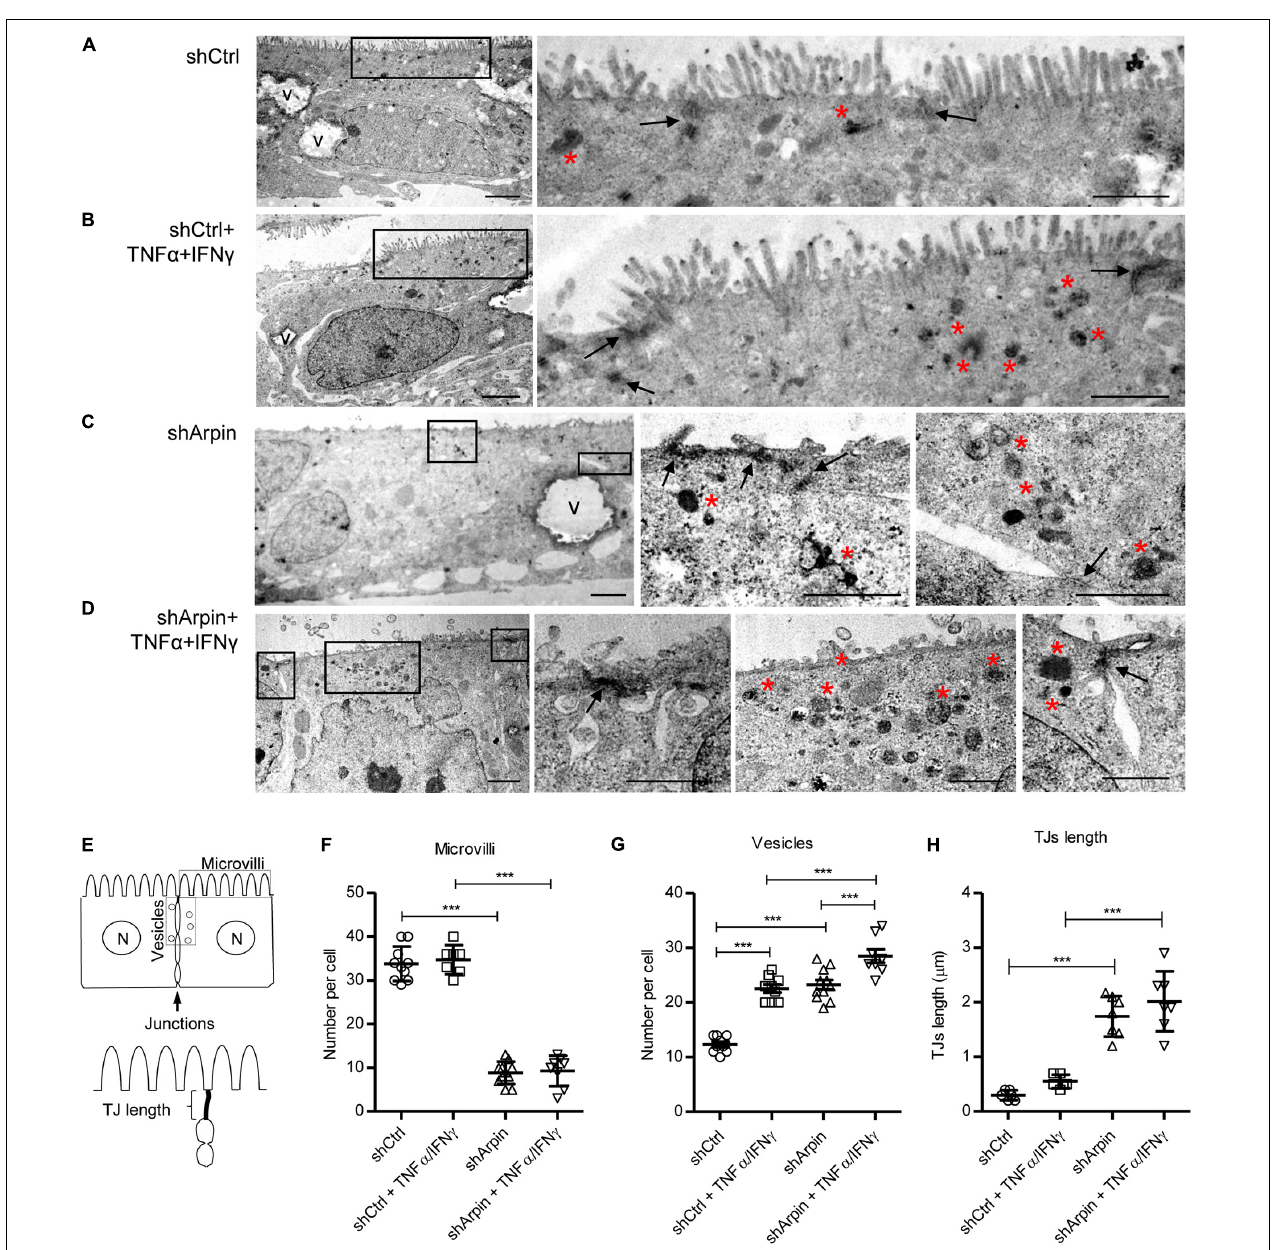
FIGURE 3 | Arpin depletion alters the ultrastructure of intestinal epithelial cells. Morphology of resting (A) and tumor necrosis factor (TNF) α /interferon (IFN) γ -treated (B) control cells (shCtrl). Morphology of resting (C) and TNF α /IFN γ -treated (D) arpin-depleted cells (shArpin). In the low-magnification micrographs on the left, overall morphology of entire epithelial cells can be observed (V, vacuoles; bar = 2 µ m). Frames indicate areas from which the high-magnification images (on the right) were taken. Arrows indicate tight junctions at the apical-most cell contacts. Red asterisks indicate accumulation of electron-dense endocytic vesicle (right images, bar = 1 µ m). (E) Scheme of the method for quantification of the number of microvilli, vesicles, and tight junction (TJ) length. Panels (F–H) correspond to the quantification of number of microvilli, number of vesicles, and TJ length, respectively ( n = 6–11; one-way ANOVA with post hoc Tukey test). *** p <